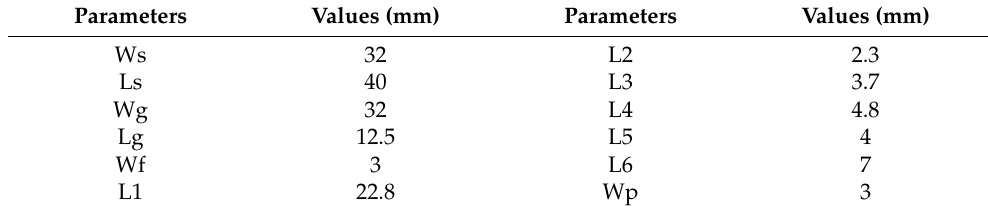
Figure 2. The view of fabricated prototype with biasing circuit.